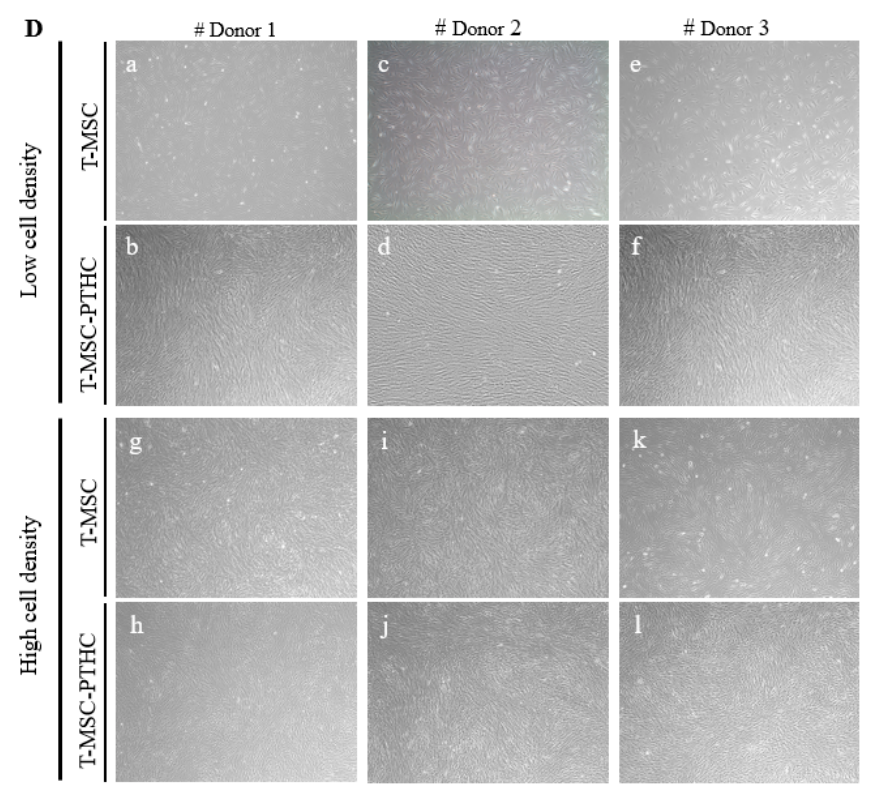
Figure 1. The effect of cell density on differentiation into PTH-releasing cells (PTHCs) from T-MSCs: ( A ) schematic representation of the differentiation protocol into the T-MSC-PTHCs. T-MSC seeded at a low cell density (50% confluence, and ( B ) a high cell density (100% confluence), ( C ) for differentiation. The number of PTH mRNA copies of T-MSC and T-MSC-PTHC from three donors were quantified and compared, respectively, using digital droplet PCR. Data are presented as mean ± SD from at least three independent experiments. The statistical analyses were performed using Student’s t -test (* p < 0.05, *** p < 0.001, **** p < 0.0001). PTH gene expression was significantly more increased in high cell density ( C ) than in low cell density ( B ) from all donors (#1~3); ( D ) the images of all the wells from 3 donors showing 50% and 100% confluence on day 0 (D0) and Day 7 (D7) (×40). Abbreviations: PTH, parathyroid hormone; T-MSC, tonsil-derived mesenchymal stem cells; T-MSC-PTHCs, T-MSC-derived PTH-releasing cells; Shh, Sonic hedgehog.